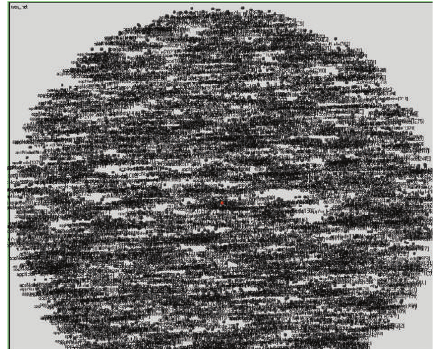
Figure 17: Randomly deployed